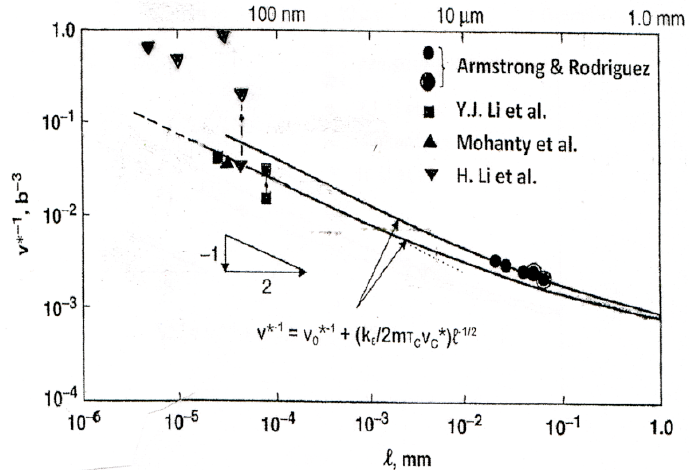
Figure 4. An H-P dependence for (1/v*) measurements made on nickel materials including nano-scale grain size strengthening and weakening measurements; the upper curve is at 77 K and lower one, 300 K.